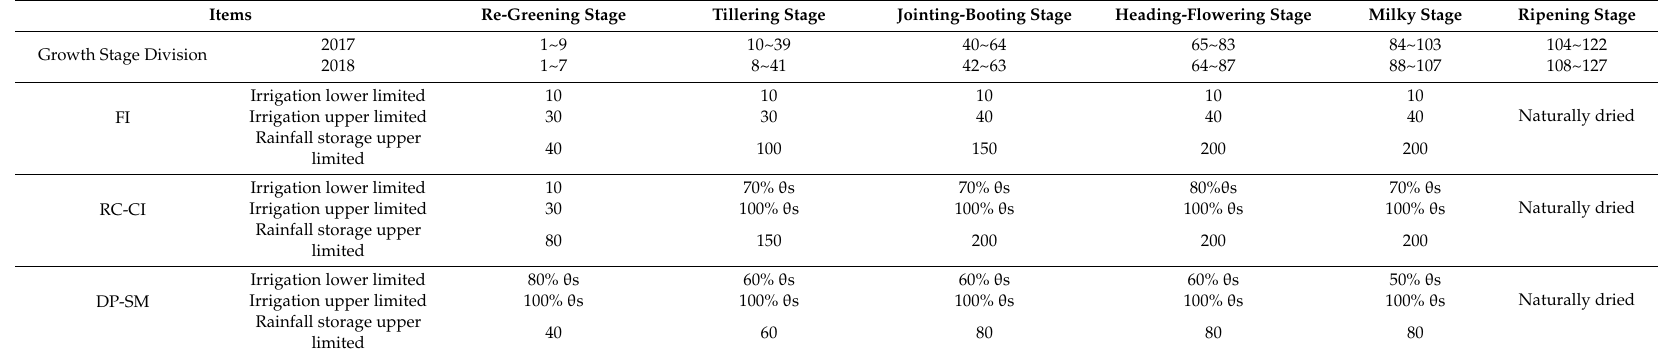
Table 1. Controlled thresholds in di ff erent stages for di ff erent irrigation